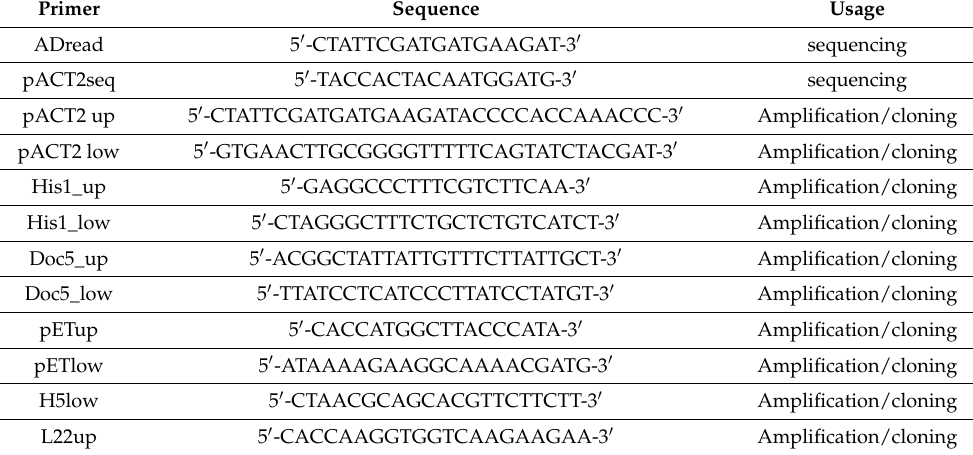
Table 1. List of primers used in this